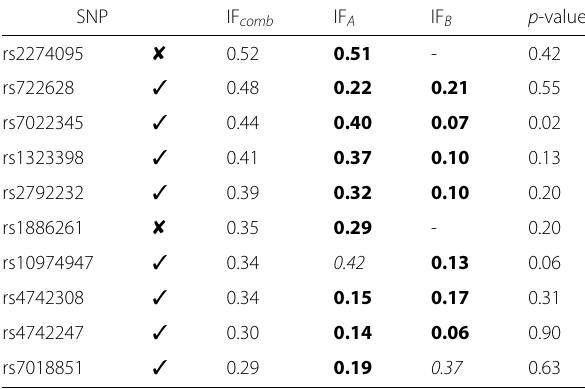
Table 3 Top 10 SNPs according to IFs for the combined data analysis ( IF comb ) in decreasing